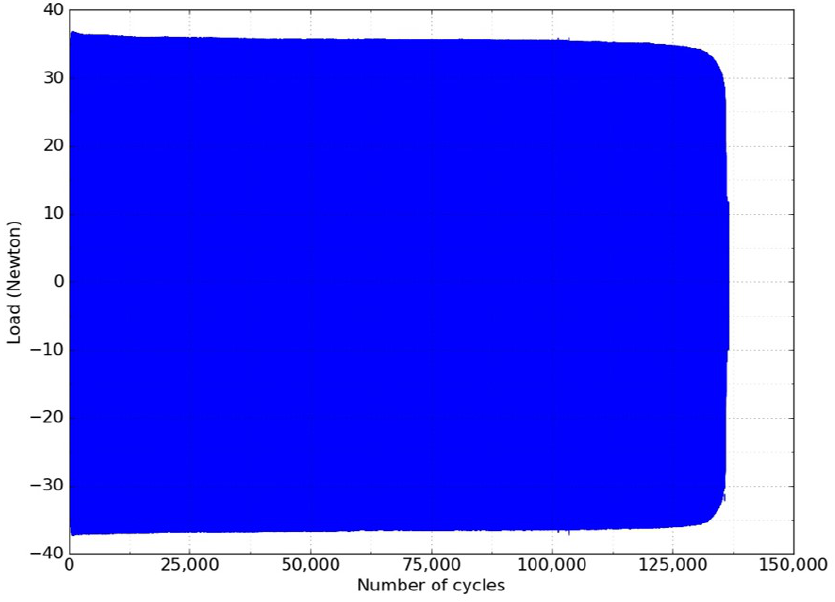
Figure 12. Load values for the specimen displaced at 0.200 mm